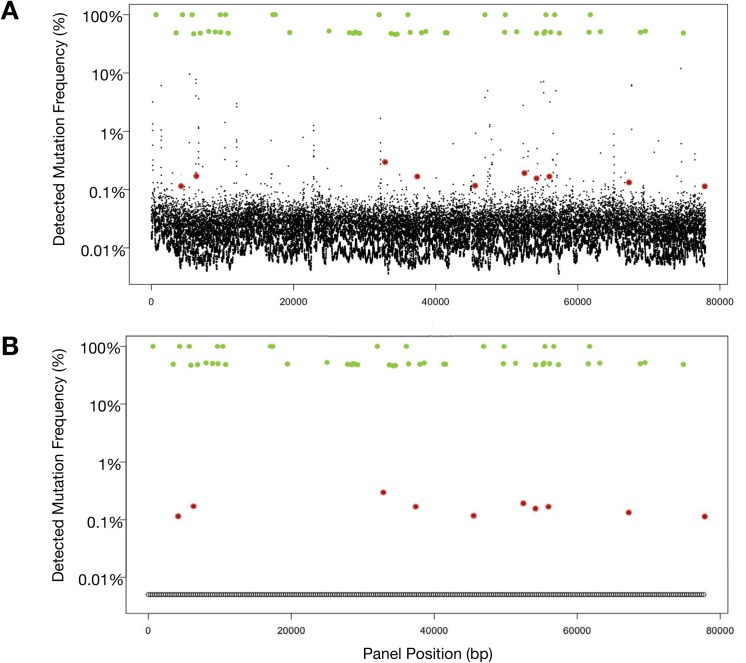
Fig 2A illustrates output from Illumina HiSeq using standard library prep on cell-free DNA sample spiked with samples from ten cell lines with known single nucleotide variant (SNV) mutations. Germline single nucleotide polymorphisms (SNPs) (green dots) at either 50% (heterozygous) or 100% (homozygous) mutant allele fractions (MAF). In contrast, the ten somatic SNVs (red dots) are quantitated at much lower MAF typically encountered with cell-free circulating tumor DNA, and are obscured by the false positive “noise” associated with low DNA concentrations. The larger the targeted region, the more false positive signals are encountered. In this actual sample, sequencing the long targeted region (78 kbp) required for the 54-gene panel results in 224 false positives at the 0.1% to 10% MAFs, making accurate sequencing of ctDNA unworkable. Fig 2B utilizes the same sample as in Fig 2A but was analyzed with Digital Sequencing technology. Molecular techniques in the pre-analytic/pre-sequencing phase and bioinformatics in the post-sequencing phase are employed to eliminate the “noise” in a process analogous to the signal transduction processing-enabled conversion of analog voice and television signals to digital signals. The result is sensitivity to the level of 1–2 mutated DNA fragment molecules in up to 1,000 wild type (mostly leukocyte-derived) DNA fragments overlapping the same nucleotide base position, essentially eliminating the false positives normally encountered at low MAFs when sequencing large targeted regions.